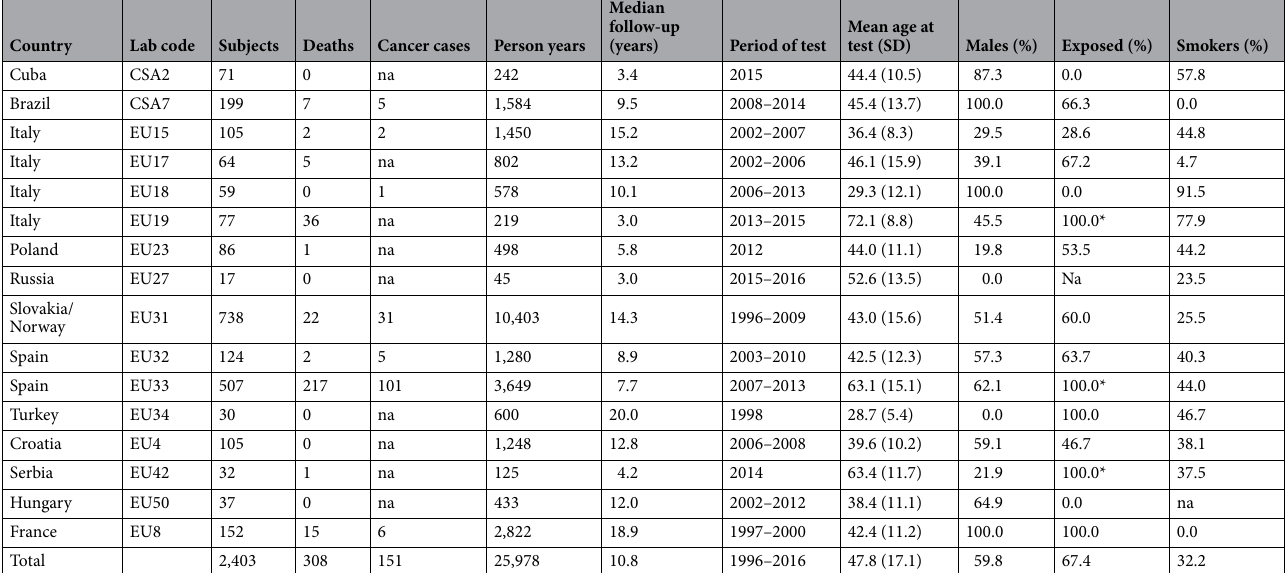
Table 1. Selected characteristics of national cohorts. The hCOMET cohort study. na: not available; *NCD Patients.